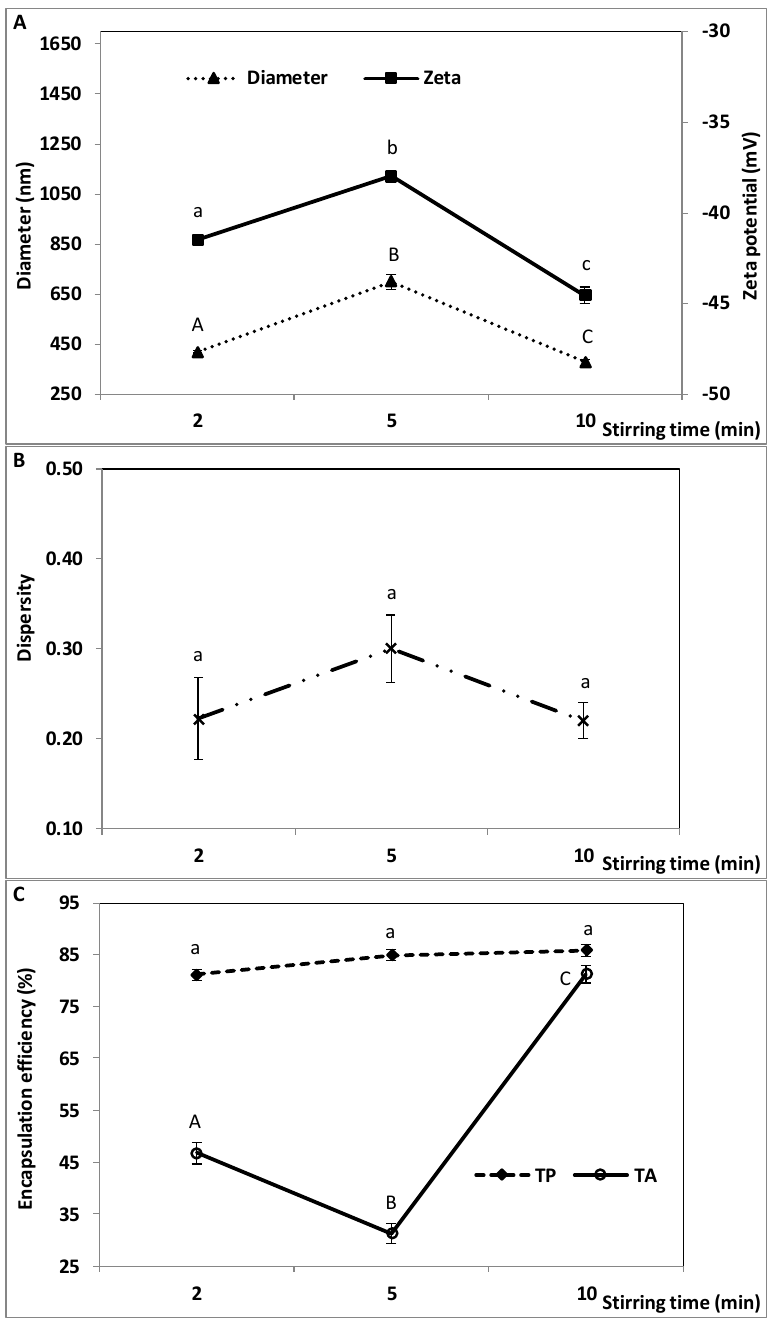
Figure 4. Effect of W 1 /O homogenization stirring time on the characteristics of the double emulsion, ( A ) droplet diameter, zeta potential, ( B ) size dispersity, and ( C ) encapsulation efficiency of total polyphenols (TP) and total anthocyanins (TA). W 1 /O homogenization speed: 10,000 rpm; W 1 /O/W 2 homogenization speed, time and microfluidization pressure: 6000 rpm, 15 min and 50 MPa. Means (three replicates) ± SD. Means with different letters in each series are significantly different ( p ≤ 0.05).